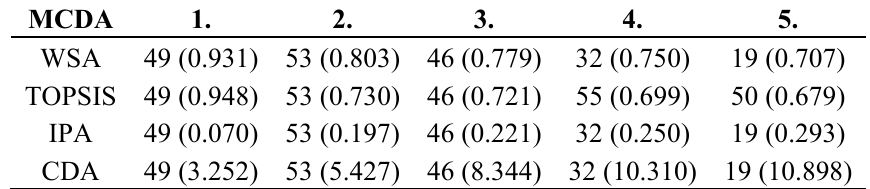
Table 13. Final MCDA scores for environmental evaluation of roof structures.